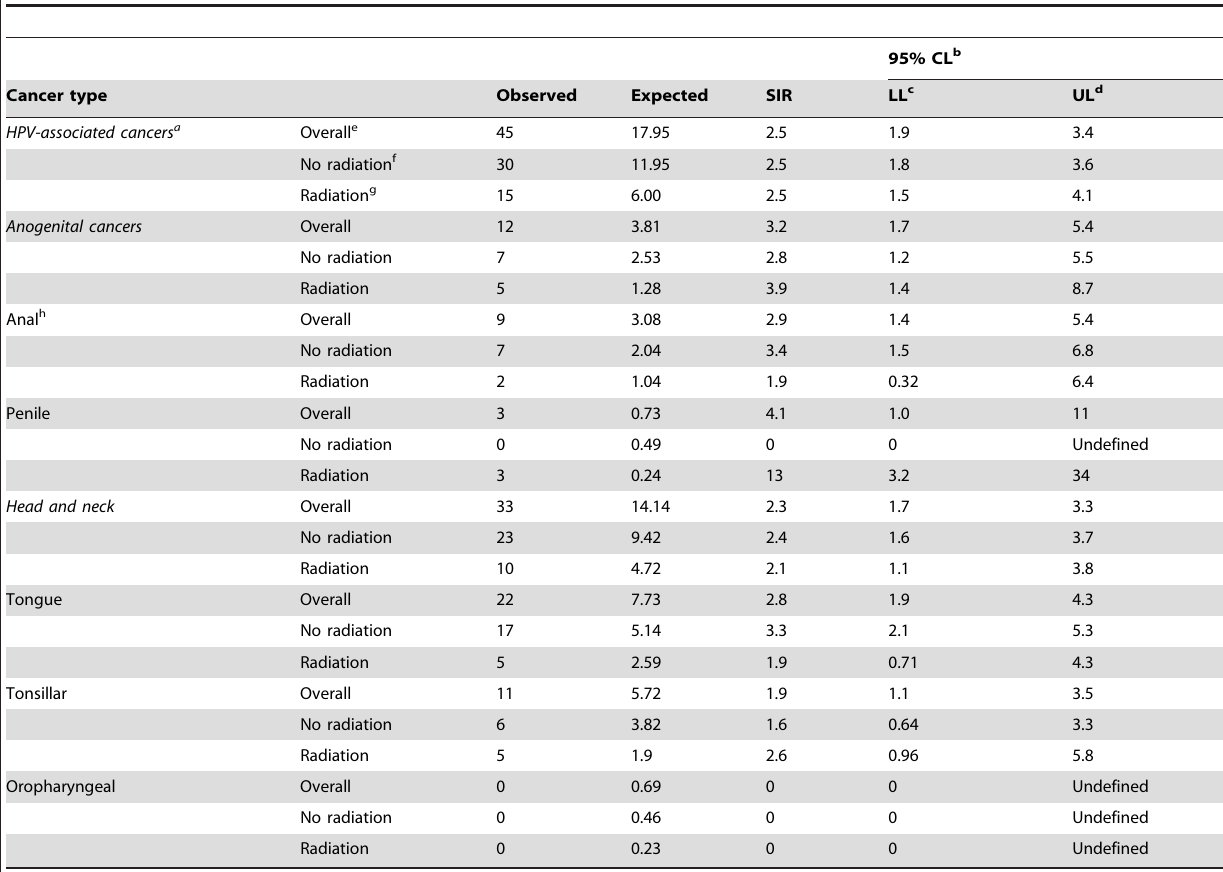
Table 3 . Standardized incidence ratios (SIRs) for human papillomavirus (HPV)-associated malignancies among male survivors of pediatric and young adult (PAYA) cancers, 1973 to